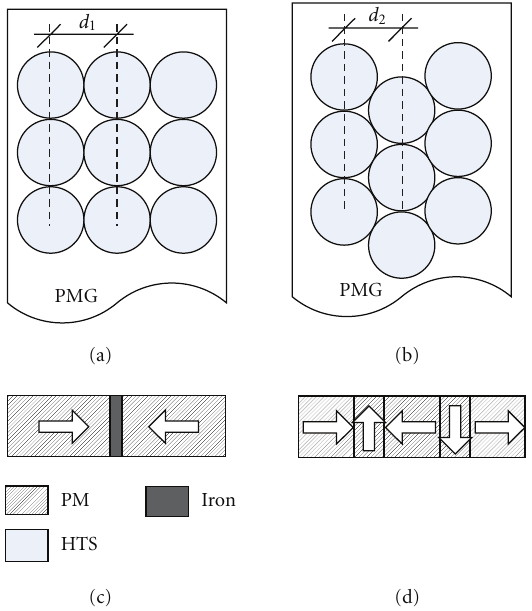
Figure 1: The two cylindrical bulk HTS arrays above PMG and the schematic diagram of two types PMG (a) bulk HTS side-by-side array (b) bulk HTS stagger array (c) symmetrical PMG (d) Halbach PMG.